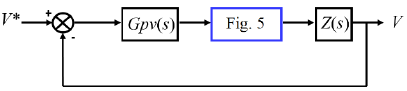
Figure 9. Average value model of the outer voltage loop of the proposed system.